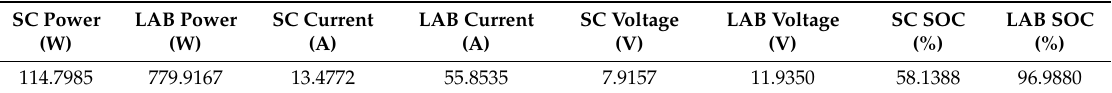
Table 2. Mean results of supercapacitor and lead acid battery (LAB) power, voltage, current, and state-of-charge